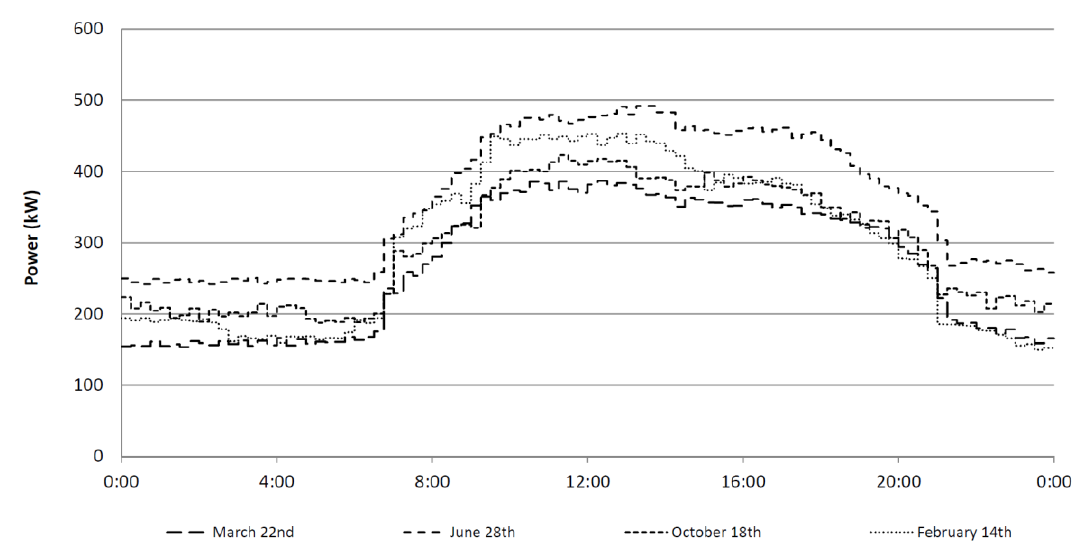
ff erent seasons before the EEM.